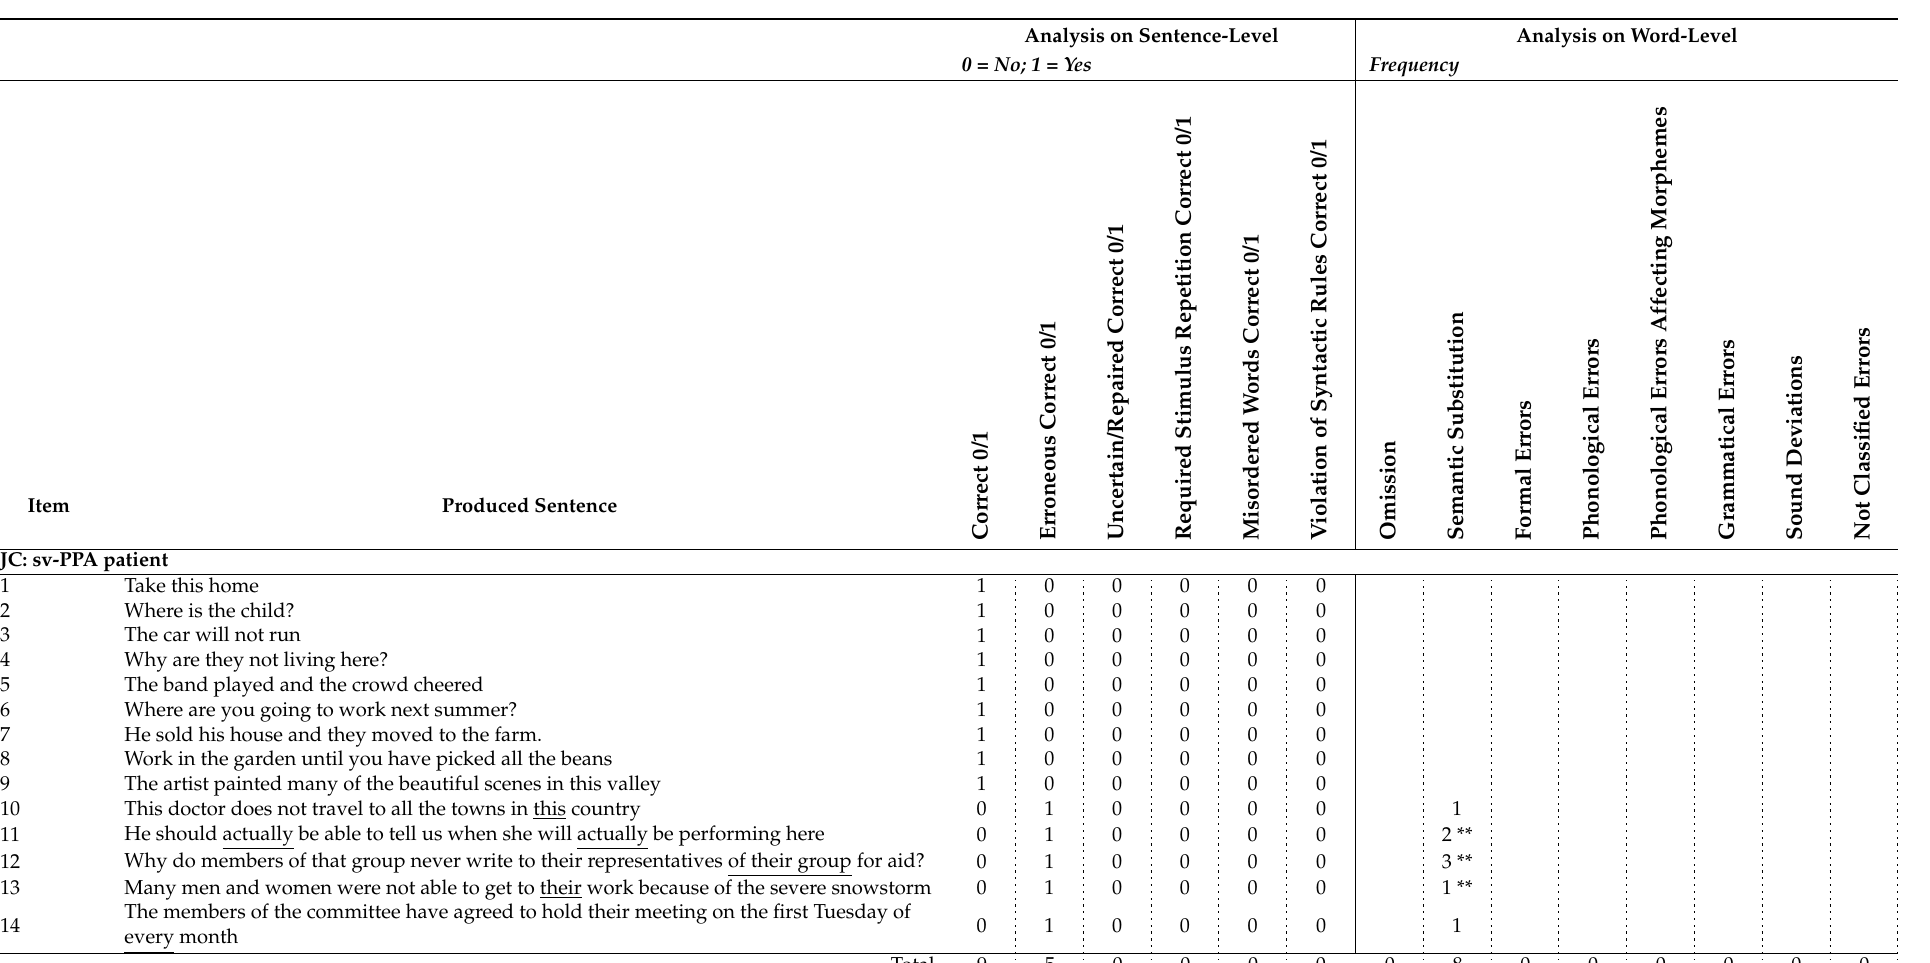
Table 2. Cont. Analysis on